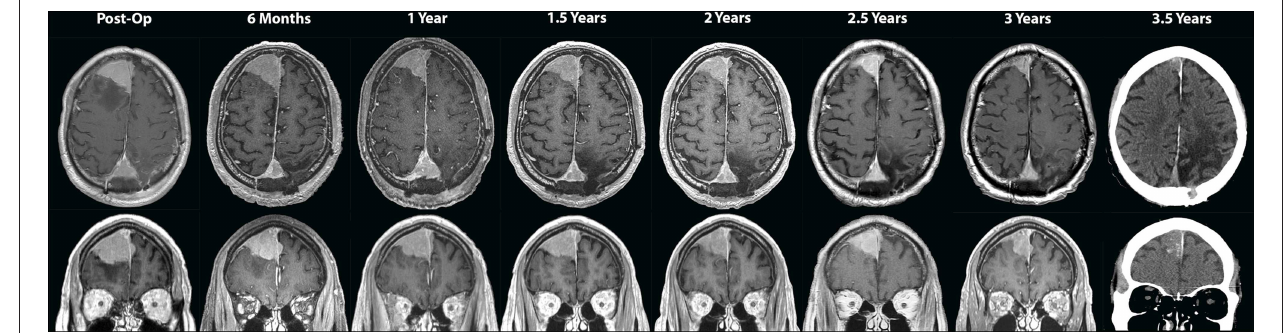
FIGURE 3 | Serial axial (top panels) and coronal (bottom panels) T1-weighted post-contrast MRI images taken every 6 months during outpatient follow-up, including the initial post-operative scan showing parasagittal parietal meningioma invading the superior sagittal sinus left as residual tumor. Follow-up scans at 6 months, 1 year, and 1.5 years show that the two lesions remained stable in size. On 2-year through the most recently taken 3.5-year scans, regression of both the left parasagittal parietal and the (untreated) right frontal lesions is visualized and attributed to the abscopal effect. A CT scan was performed for follow-up at 3.5 years due to recent placement of a non-MRI-compatible cardiac